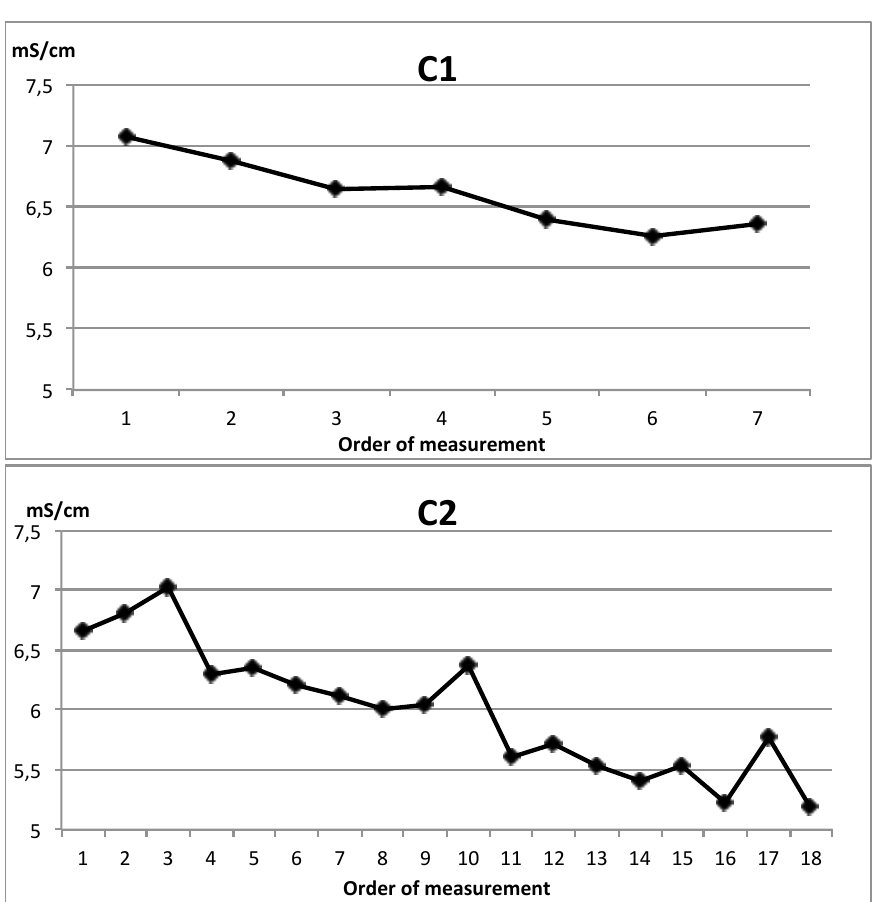
Figure 12. Examples of the evolution of EC measures during one